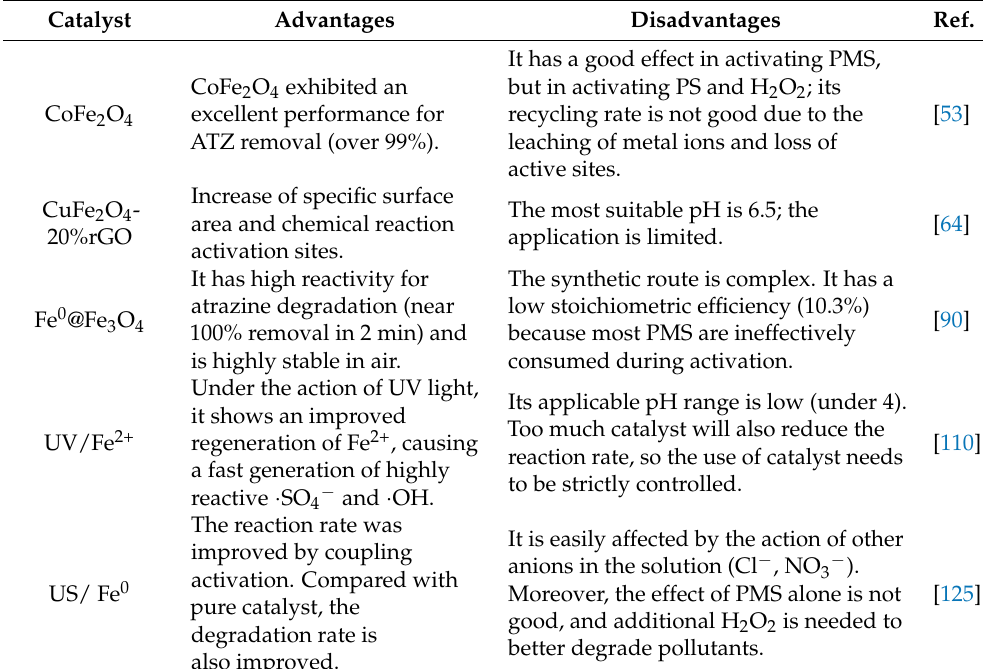
Table 7. Advantages and disadvantages of representative five iron–base catalysts mentioned